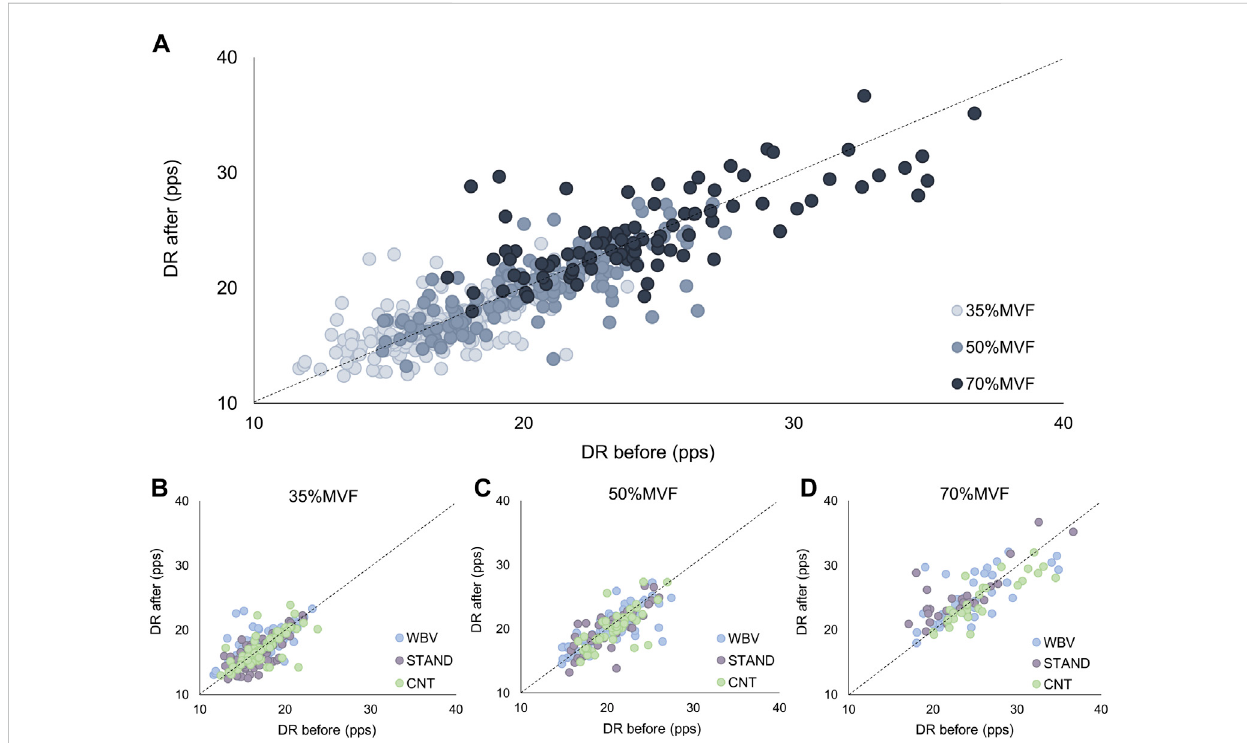
FIGURE 6 Motorunitdischargerate.Thescatter plotsofthedischargeratebefore(abscissa)andafter(ordinate) eachcondition.Itwasdisplayedfortheoverall results (A) , 35%MVF (B) , 50%MVF (C) , and 70%MVF (D)